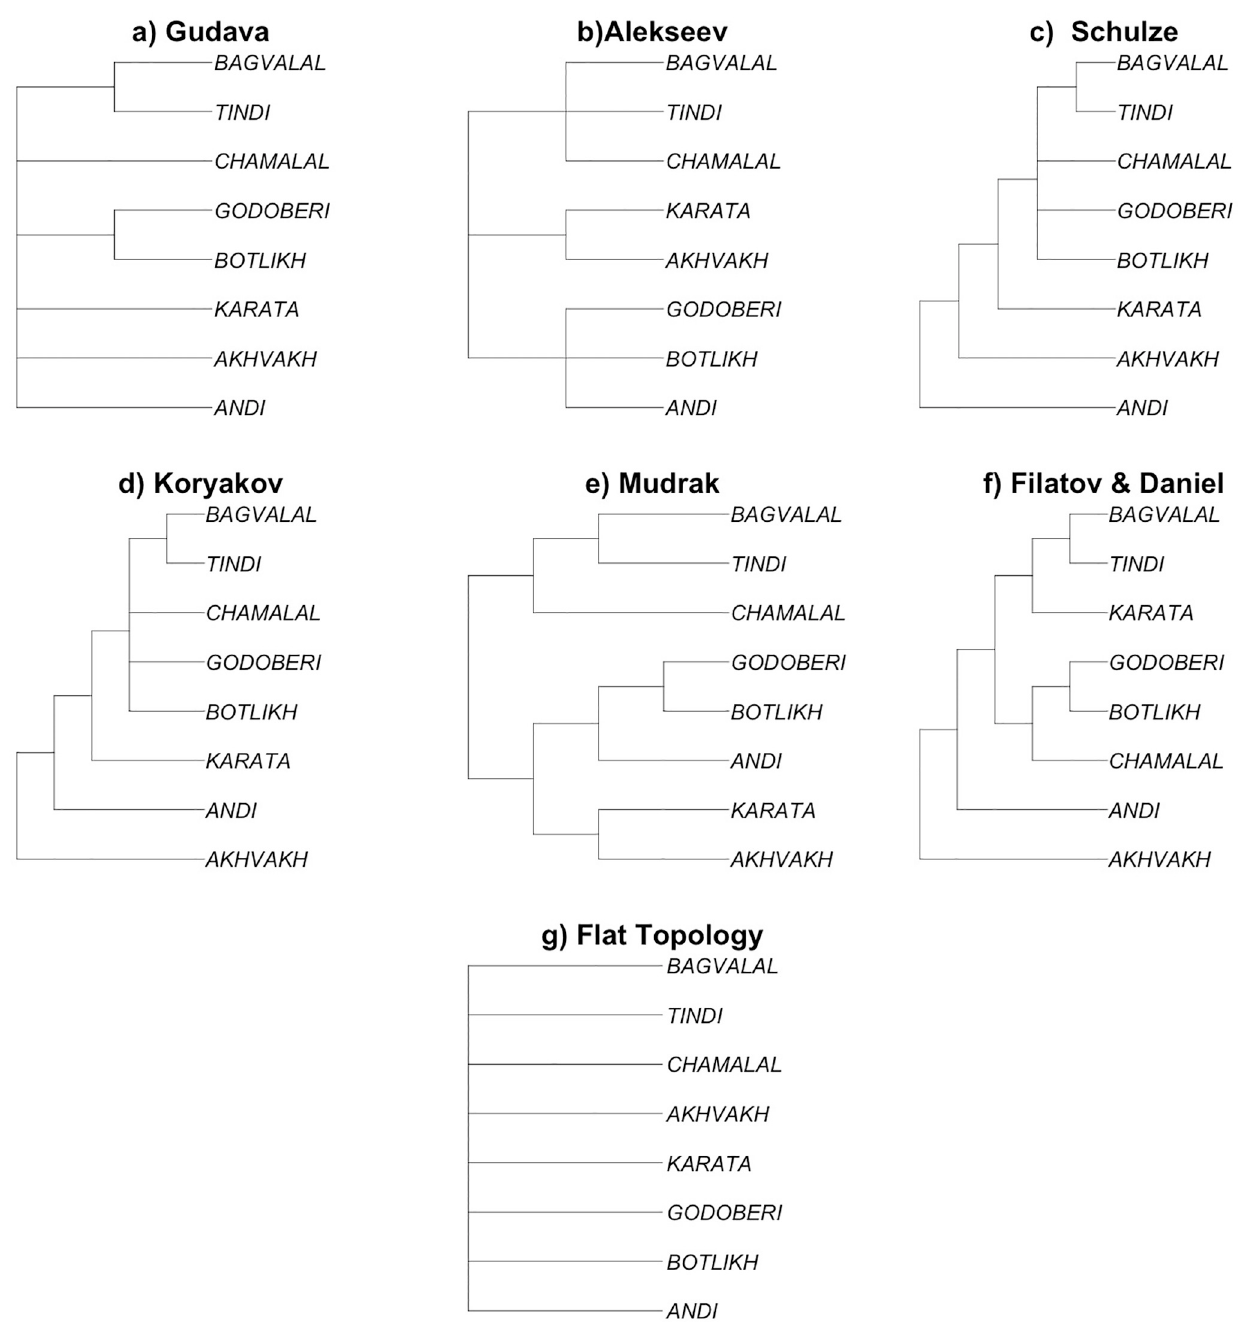
Fig 5. Qualitative classification and lexical phylogenies aligned for comparison. Tree tips are languages, and branch lengths are all plotted equally. Trees are ordered according to the time of the publishing. Flat Topology was added as a baseline for comparison.